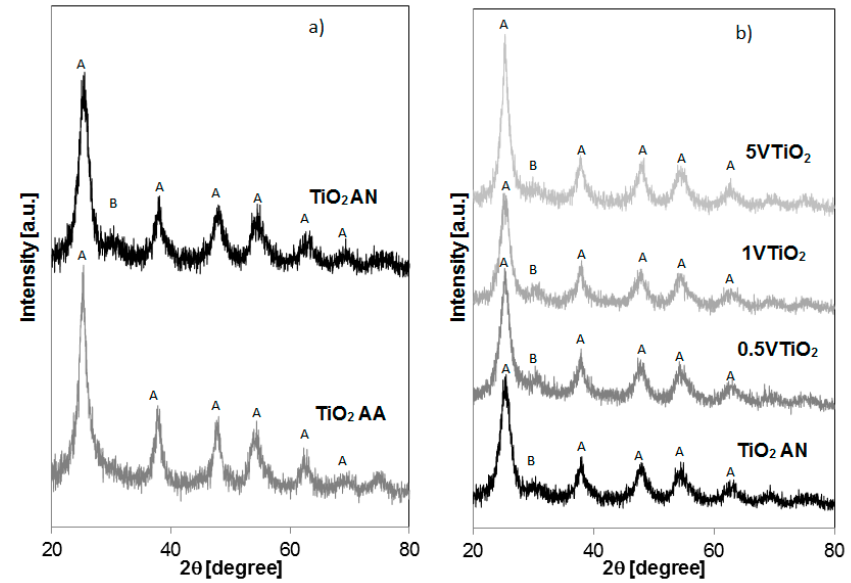
Figure 2. XRD patters of ( a ) TiO 2 AA and TiO 2 AN; ( b ) TiO 2 AN, 0.5VTiO 2 , 1VTiO 2 and 5VTiO 2 .